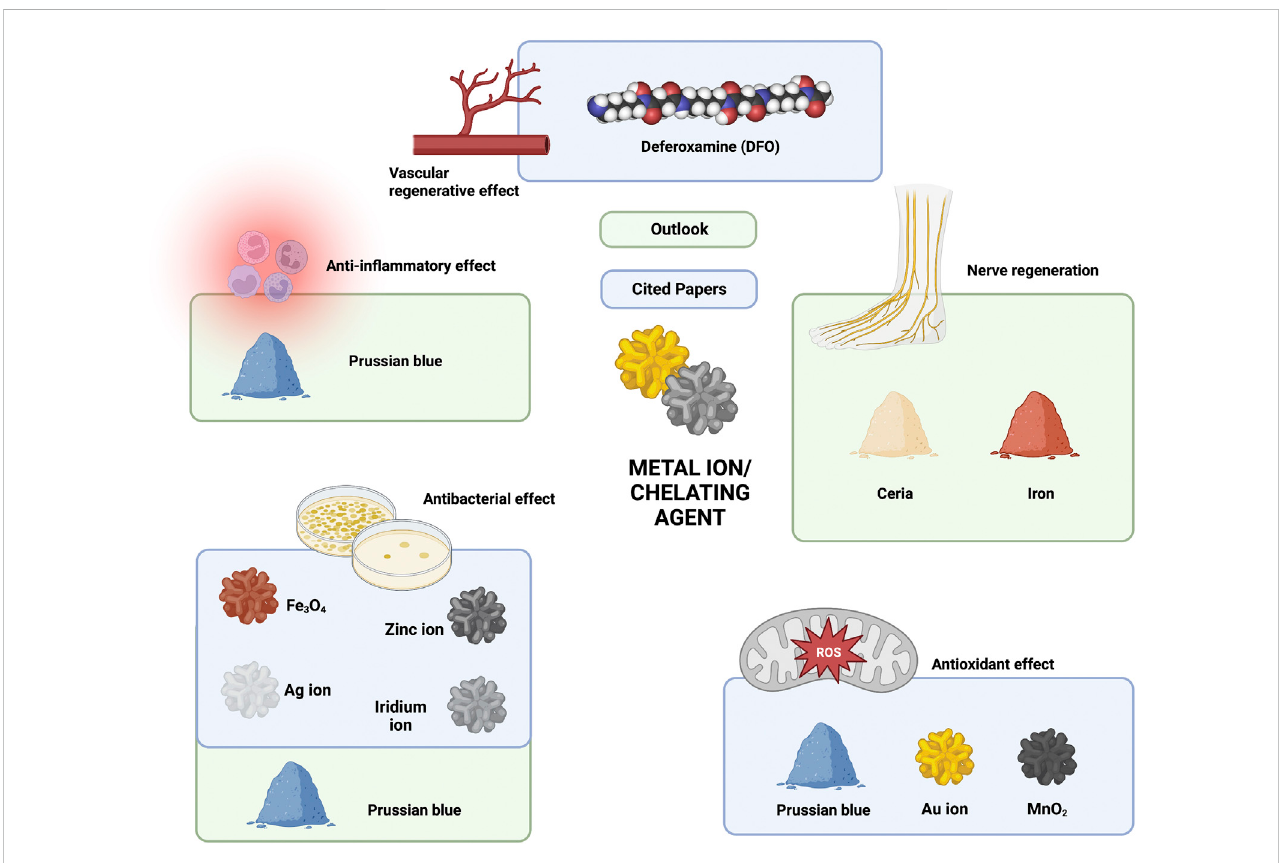
FIGURE 4 Current and future outlook of chelating agent/metal ion components in hydrogel composites in the treatment of chronic diabetic ulcers.